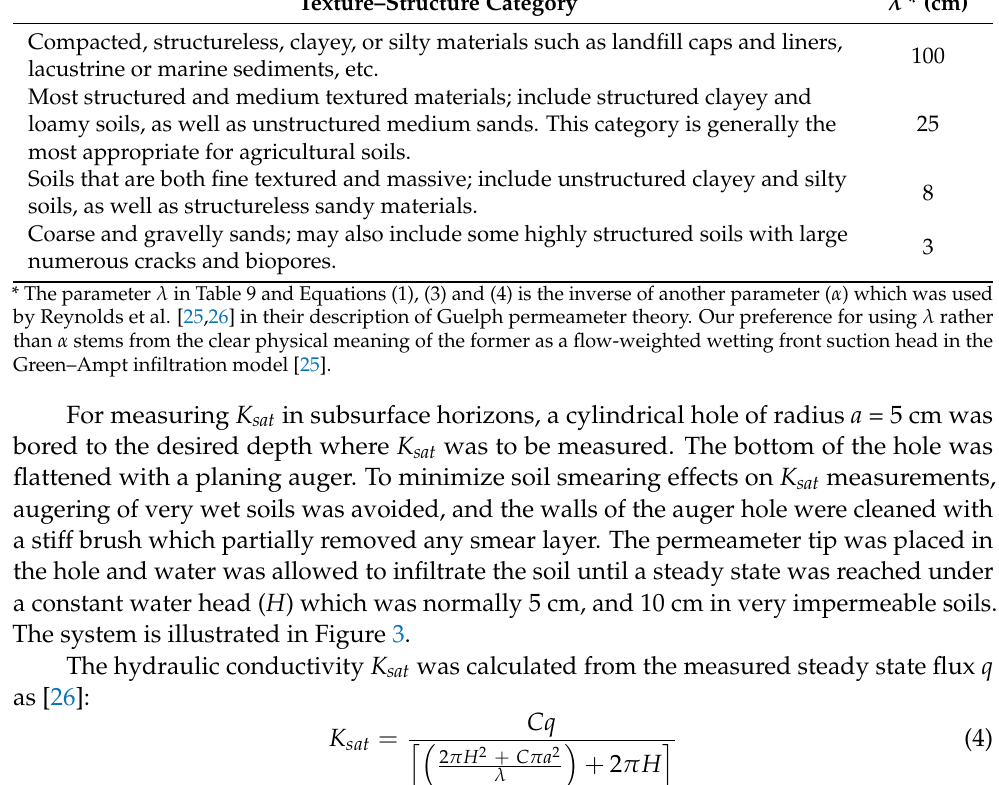
Table 4. Texture–Structure categories for visual estimation of λ . Adapted from Elrick et al. [25]. Texture–Structure